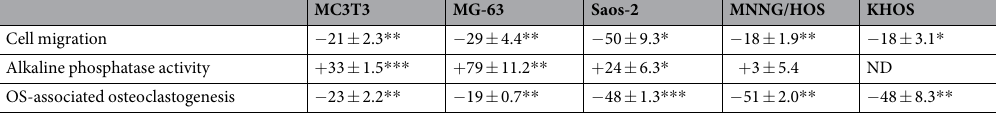
Table 1. Effect of exogenous Sema3A on the behaviour of human osteosarcoma cells in vitro . Cancer cell migration, osteoblast differentiation and osteoclast formation were assessed as described under Materials and Methods. Values are expressed as means ± SEM and are obtained from 3 different experiments. * p < 0.05, ** p < 0.01, *** p < 0.001 from vehicle treated cultures. OS denotes osteosarcoma and ND denotes non-